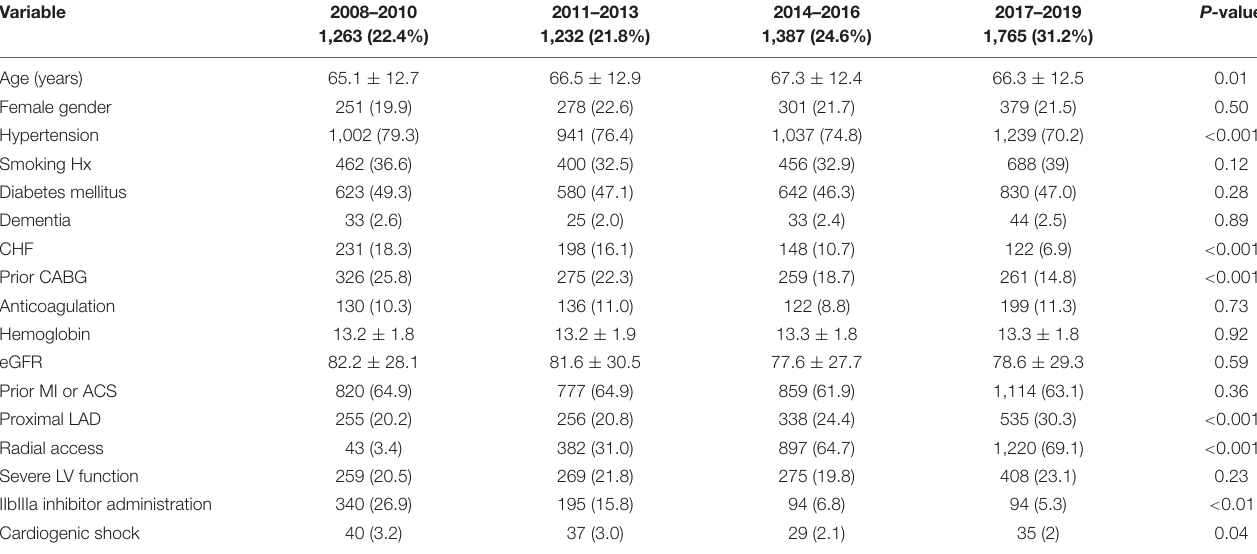
TABLE 2 | Baseline characteristics of complex PCI per